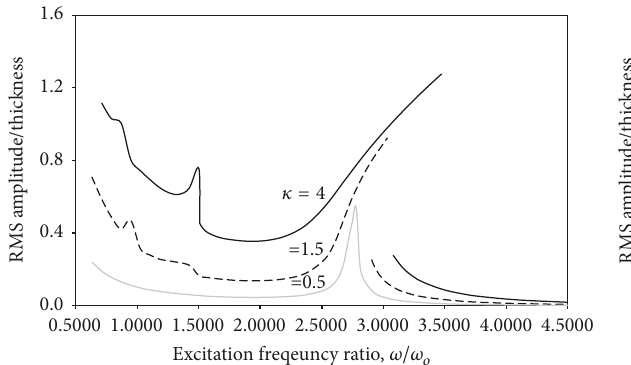
(a) Vibration amplitude versus excitation frequency for various source excitation magnitudes ( ℎ = 2 mm, 𝐿 𝑥 = 0.5 m, 𝐿 𝑥 = 0.3 m, 𝐵 = 0.4 m, 𝜉 = 0.02 , 𝑤 𝑐 = 1 mm)